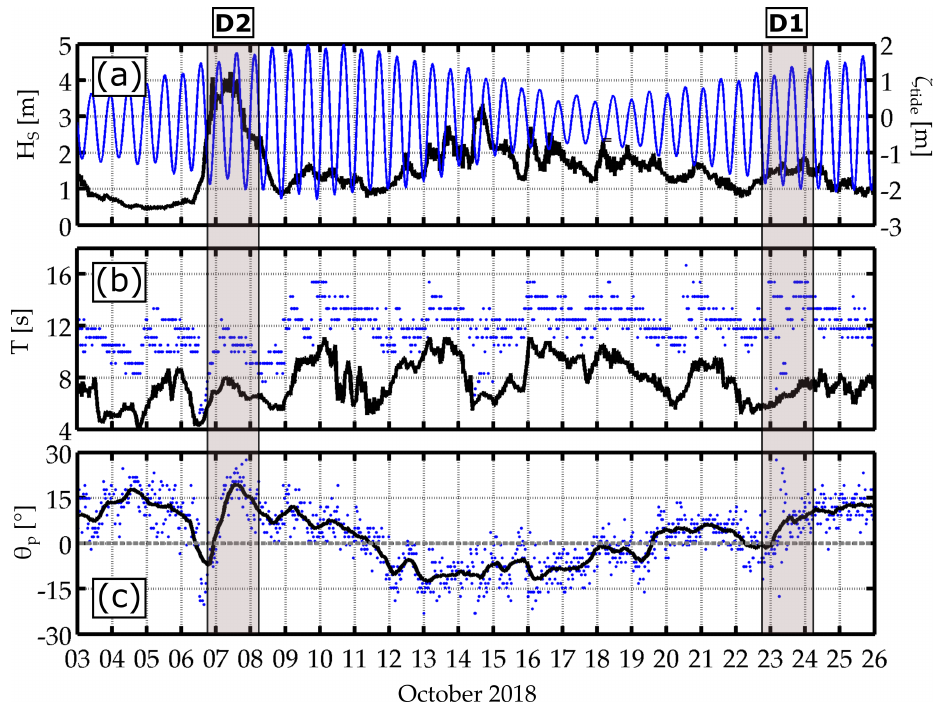
Figure 3. Offshore wave and tide conditions during the field experiment, with low- and high-energy deflection event (D1 and D2 shown by shaded areas). ( a ) Tidal level ( ζ tide ; blue line; see right axis) and significant wave height ( H s ; black line). ( b ) Peak wave period ( T p ; blue dots) and mean wave period ( T m 02 ; black line). ( c ) Peak wave angle of incidence with respect to the shore normal ( θ p ; blue dots) and its 12h-averaged values (black line). Positive values mean a deflection configuration (see Figure